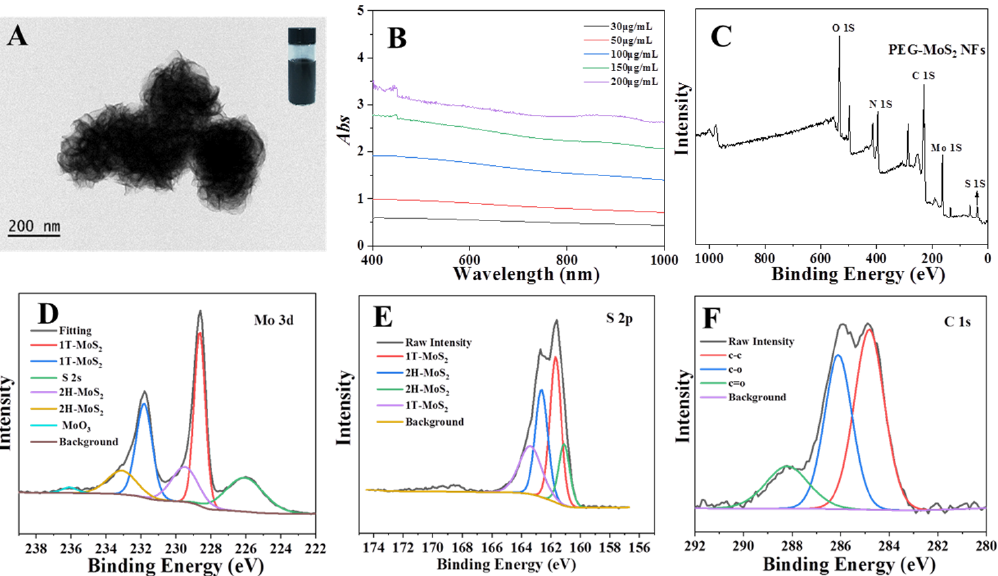
Figure 3. ( A ) TEM images of the PEG-MoS 2 NFs. ( B ) The absorption spectra of the PEG-MoS 2 NFs from visible light to the NIR region. ( C ) XPS spectra of PEG-MoS 2 NFs. ( D ) XPS spectra of Mo 3d orbits. ( E ) XPS spectra of S 2p orbits. ( F ) XPS spectra of C 1s orbits.